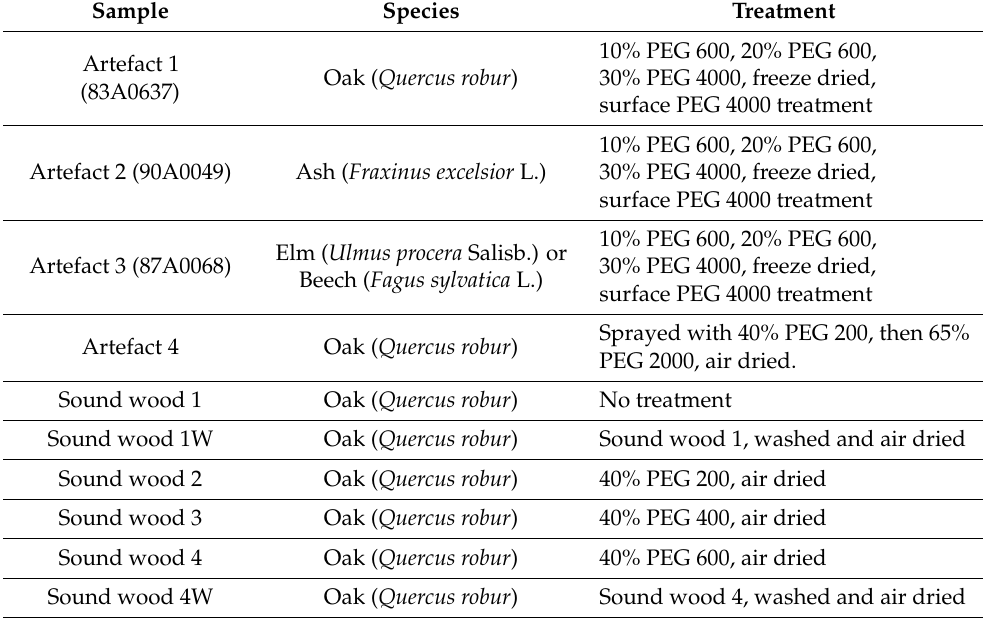
Table 1. Summary of samples used in this study. Artefacts 1 to 4 are pre-treated wood from the Mary Rose collection. The collection reference number is indicated between brackets when available. The samples “sound wood” 1 to 4 have been treated during this